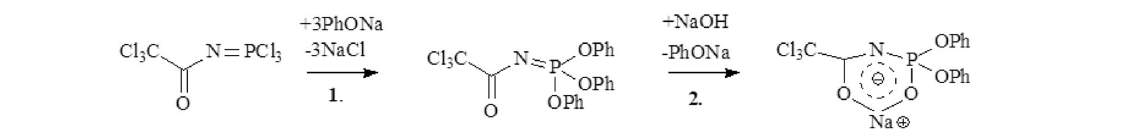
Fig. 2 Scheme of solubility of diphenyl-N-(trichloroacetyl)-amidophosphate (HL) in sodium